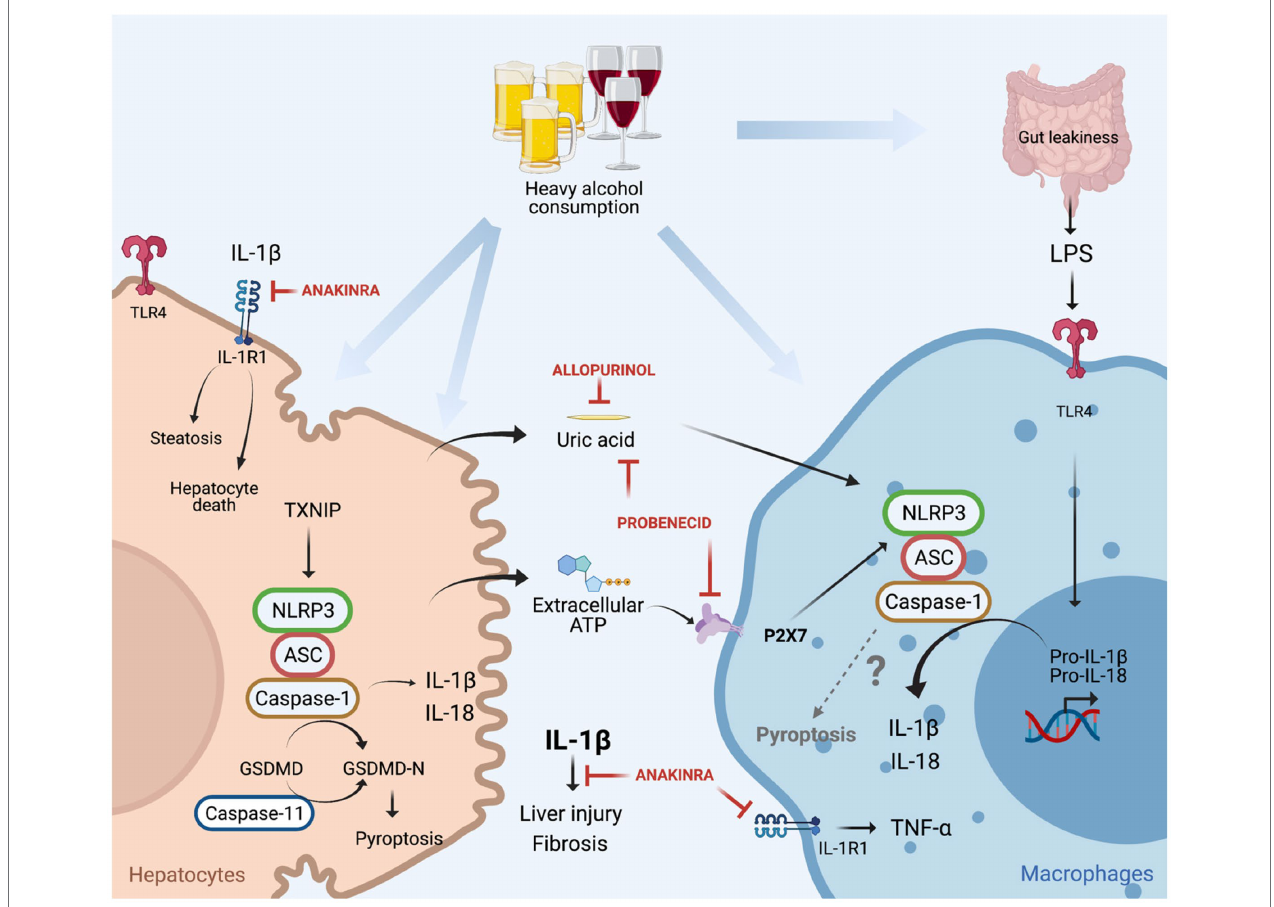
FIGURE 4 | Canonical (NLRP3/caspase-1) and non-canonical (caspase-11) inflammasome induced cell death in alcoholic-associated liver disease. Heavy alcohol consumption induces hepatocyte death leading to the release of damage-associated molecular pattern (DAMPs; ATP and uric acid) into the circulation, in addition to the translocation of gut-derived LPS to the liver as a result of leaky gut. LPS through TLR4 induces pro-IL-1 β and pro-IL-18 transcription in macrophages. Hepatocyte-derived extracellular ATP, through P2X7 signaling, and uric acid promote NLRP3 assembly, caspase-1 activation and cleavage of pro-IL-1 β into bioactive IL-1 β in LPS-stimulated macrophages for IL-1 β release. IL-1 β binds to IL-1R1 which induces hepatocytes triglycerides accumulation, hepatocyte death, macrophage activation, liver injury, and fibrosis. These effects are attenuated by treatment with anakinra (IL-1R1 antagonist), allopurinol (uric acid synthesis inhibitor), or probenecid (uric acid reducer and ATP signaling blocker). In hepatocytes, alcohol induces NLRP3/caspase-1 activation through TNXP1 protein interaction, culminating in pyroptosis. Alcohol-induced activation of caspase-11 in the liver, and overexpression of constitutively active gasdermin D (GSDMD) in hepatocytes leads to pyroptosis and liver